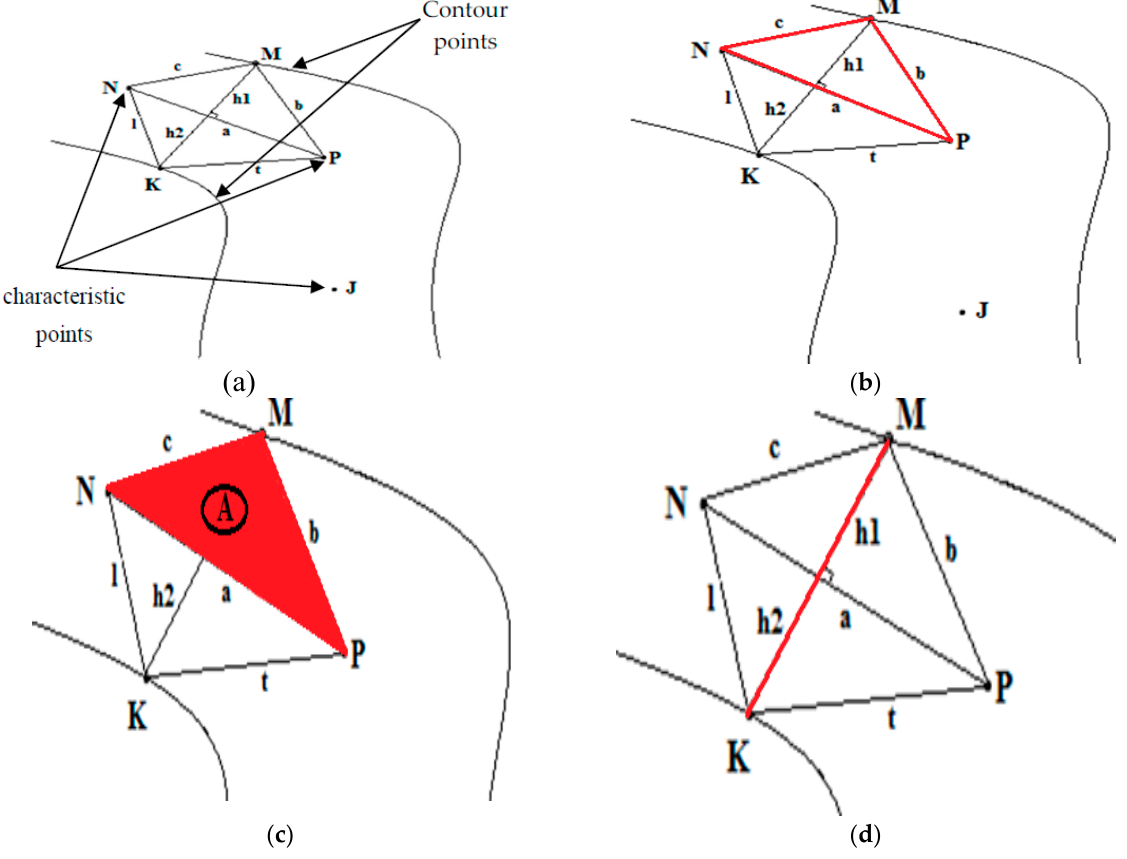
Figure 6. Technique used for the determination of the blood vessel diameters: ( a ) Presentation of the basic elements used (the two black arrows represents the Contour points and the three other black arrows represents the characteristic points); ( b ) Find the perimeter of a triangle; ( c ) Calculate the area of a triangle; ( d ) Calculate the heights of the triangles and the blood vessel diameters.